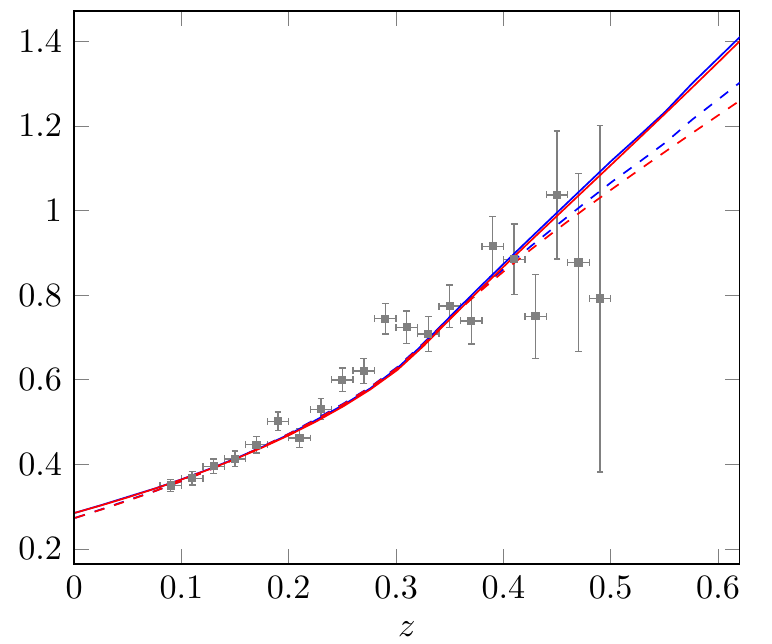
2 (upper solid and dashed lines, in blue) and W +;2L ( z ) j j 0 : 593, b + = 0 : 675, (cid:12) + = (cid:0) (cid:0) 0 : 683, (cid:12) + = 0 : 85 10 (cid:0) 8 (dashed lines). The data points shown on (cid:0) (cid:0) (cid:1)